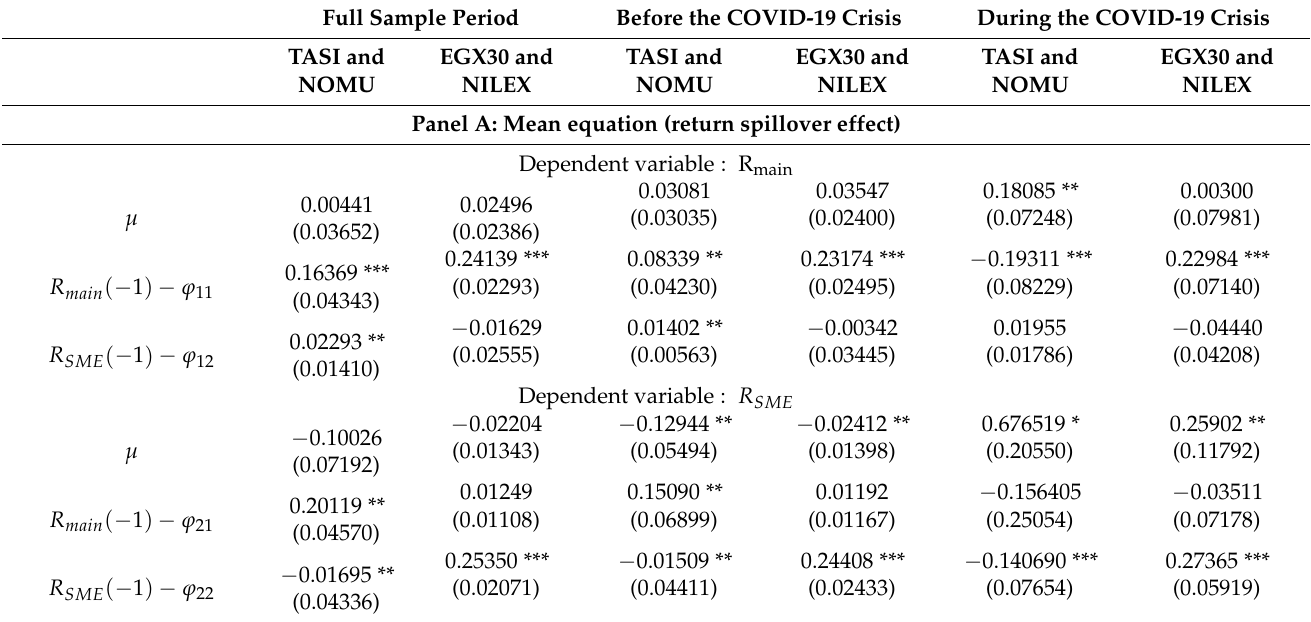
Table 4. Estimation results of the bivariate VAR (1)-asymmetric BEKK–GARCH (1,1) model. Full Sample